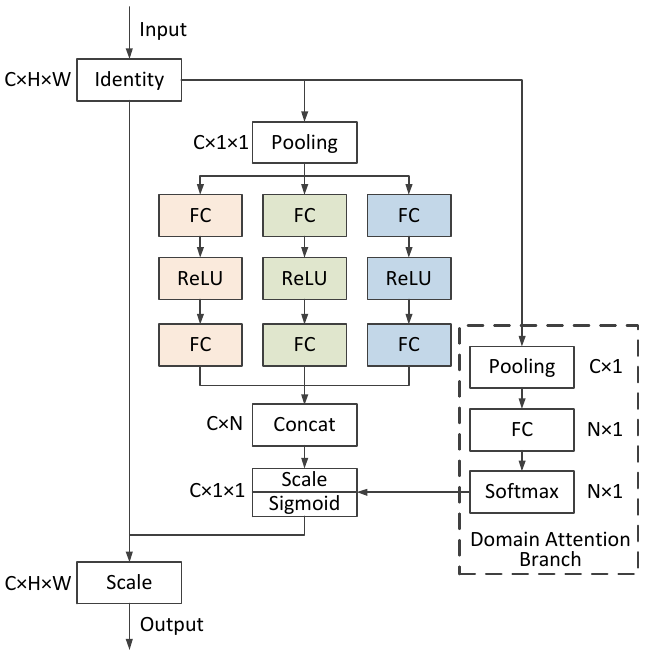
Figure 5. Structure of the channel domain attention